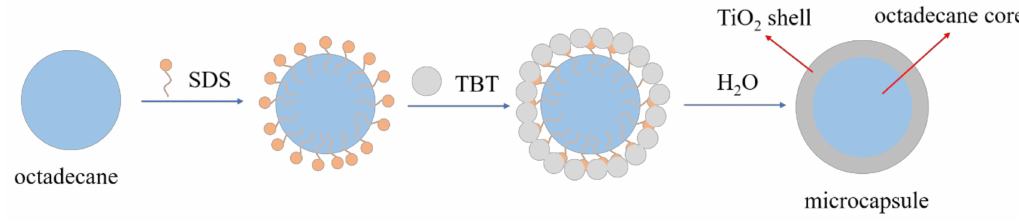
Figure 1. Schematic illustration of the synthesis process of n-octadecane@TiO 2